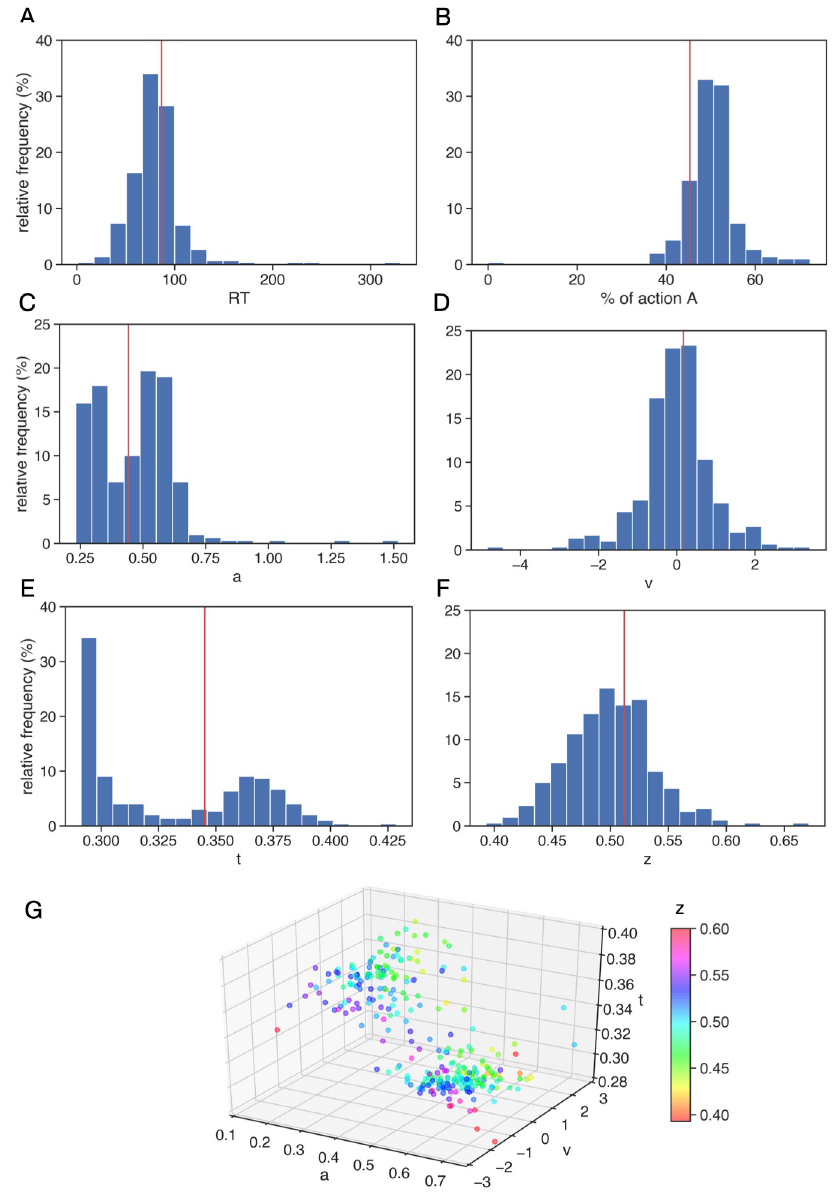
Fig 5. Histograms of simulated behavioral data and best fit DDM parameter values. Panels A and B display the histograms of the reaction times (RT, averaged over 300 trials) and the percentage of choice A (also averaged over 300 trials) across 300 networks generated via the LHS procedure. For each network, the distribution of RTs and accuracy on each trial were used to estimate the DDM parameters ( a , ν , t , z ), which are represented in histograms in panels C-F. The vertical red lines in panels A-F correspond to the specific value obtained for the permuted network based on the control conductances (Fig 4). Panel G is a 3D representation of the ( a , ν , t ) parameter space with parameter z represented by the colorbar, which is capped at 0.6 (despite one outlier at z > 0.65 and another at z 2 (0.6, 0.65); see panel F). In this panel, each dot represents the ( a , ν , t , z ) vector obtained using the HDDM algorithm for a specific sampled